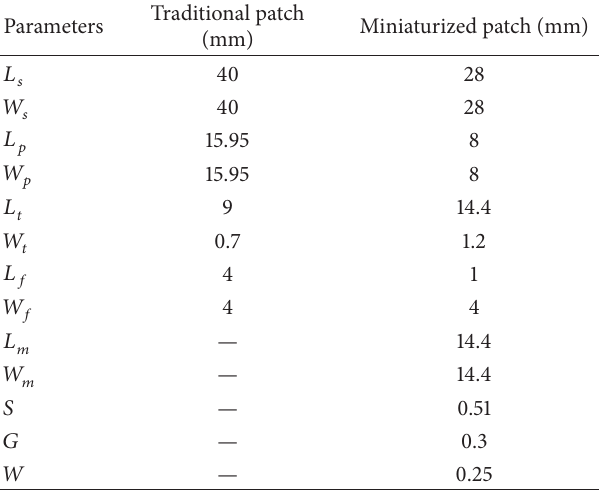
Table1:Physicalparametersofthetraditionalantennawithquarter- wave transformer and miniaturized patch